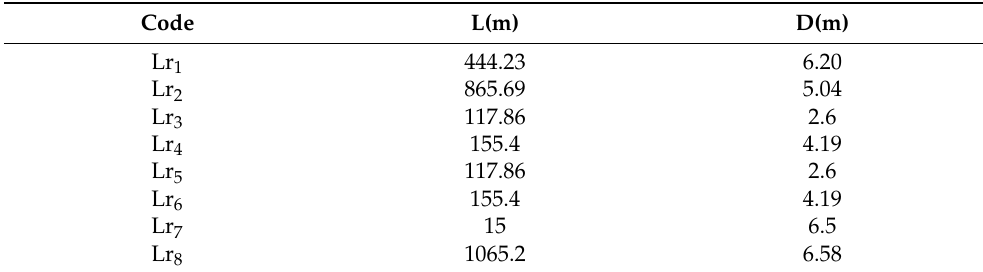
Figure 1. Typical layout of two hydraulic couplings pumped storage units (PSUs). Table 1. The parameters of each pipe section.